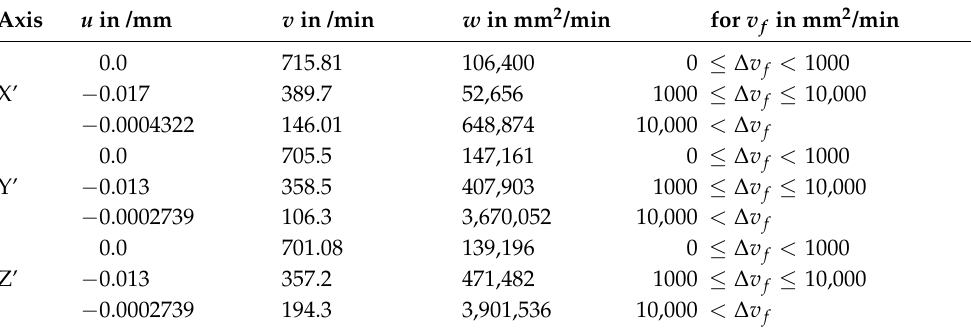
Table 2. Parameter values of the acceleration